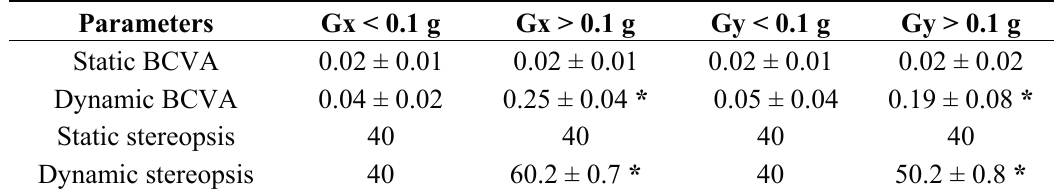
Table 1. Results of VA and stereopsis in the ground (static condition) and during acceleration (dynamic condition) from two directions (X- and